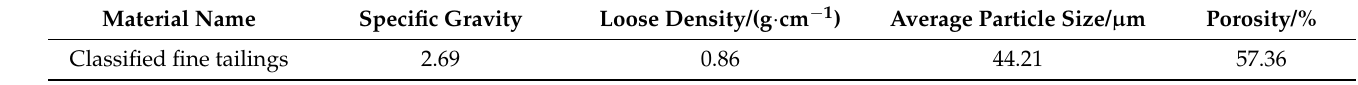
Table 1. Physical properties of classified fine tailings.